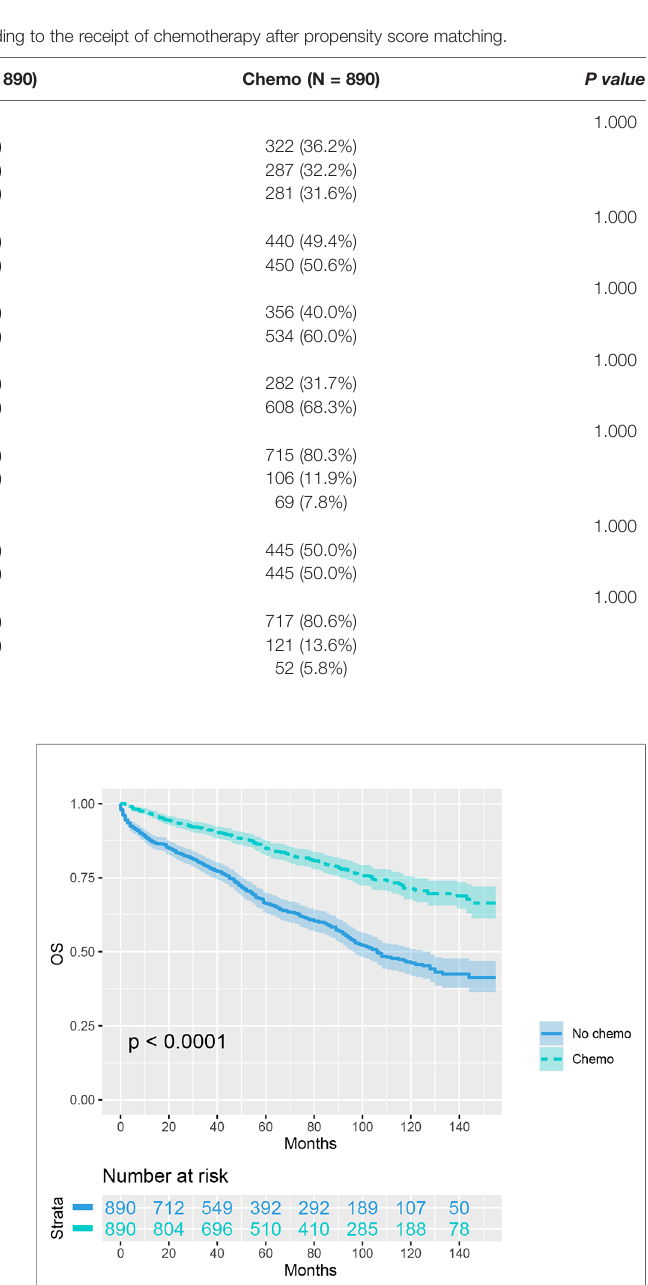
FIGURE 4 | Kaplan-Meier plot, revealing the overall survival differences based on the receipt of adjuvant chemotherapy in T1N+ colon cancer patients after propensity score